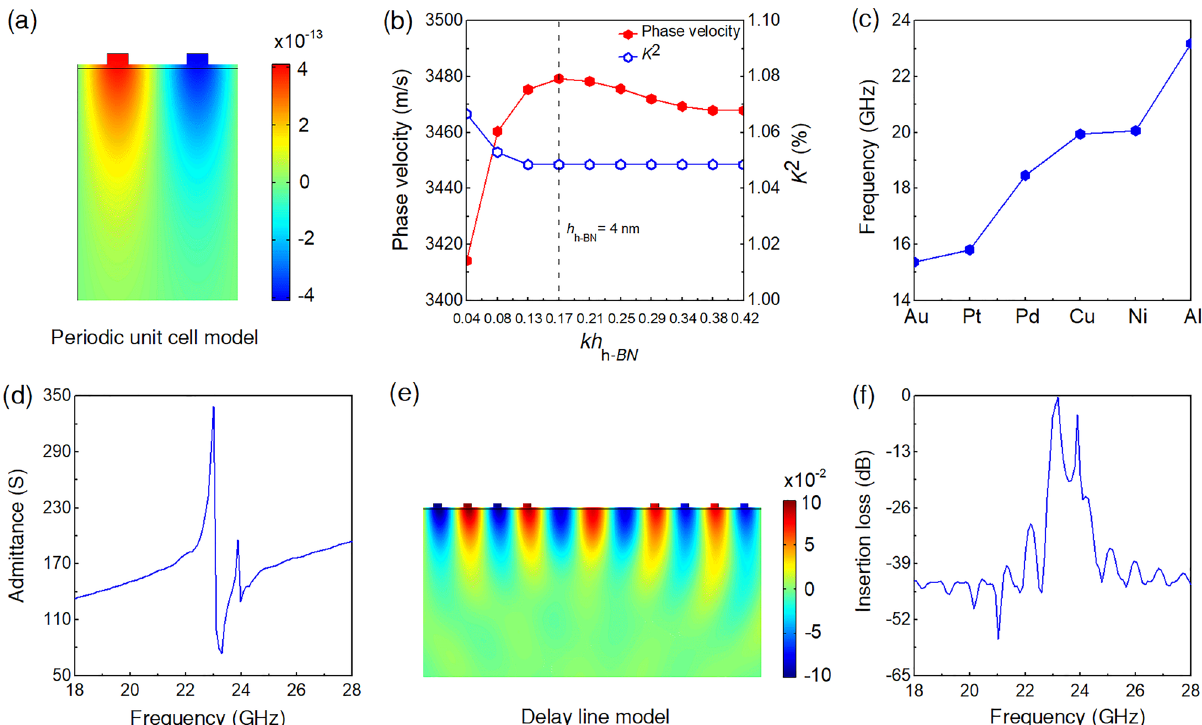
Figure 2. Frequency characteristics of h-BN/SiO 2 layered structure. ( a ) Displacement field distribution (in nm) of a unit cell with 4 nm thick h-BN at Rayleigh mode frequency (23 GHz). ( b ) kh h-BN dispersion curves of phase velocity and electromechanical coupling coefficient ( K 2 ). ( c ) Comparison of Rayleigh modes with different IDT metals. ( d ) Electrical input admittances vs. frequency near Rayleigh mode of delay line simulation with input and output IDTs. ( e ) Displacement field distribution of delay line simulation at Rayleigh mode. ( f ) Insertion loss ( S 21 ) of h-BN/SiO 2 SAW filter from delay line